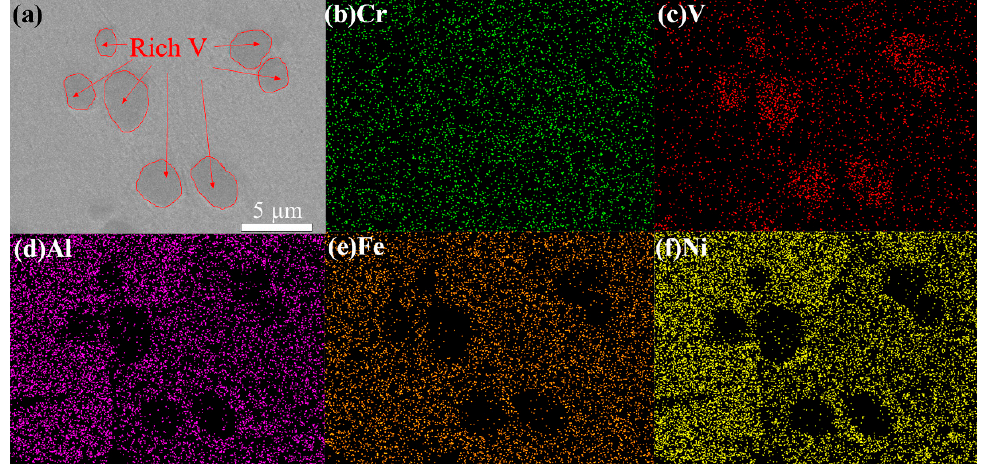
Figure 1. ( a ) SEM image of AlCrFeNiV and corresponding EDX mapping showing spatial distribution of ( b ) Cr, ( c ) V, ( d ) Al, ( e ) Fe, ( f ) Ni of the investigated area.